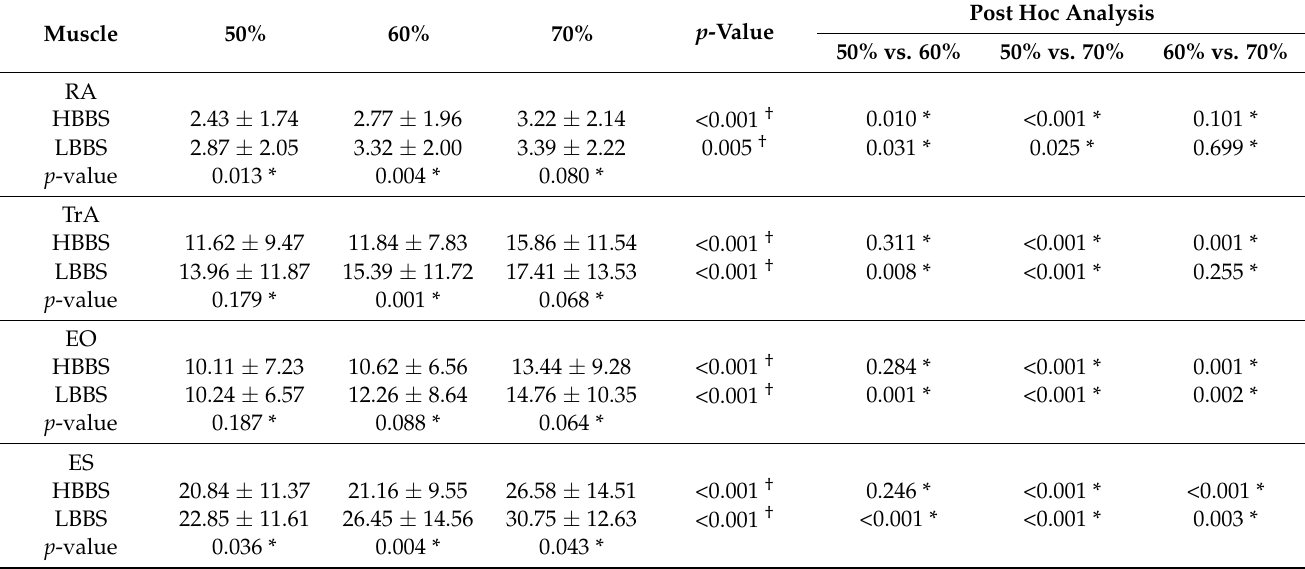
Table 5. Comparison of the muscle activity of the trunk during the concentric